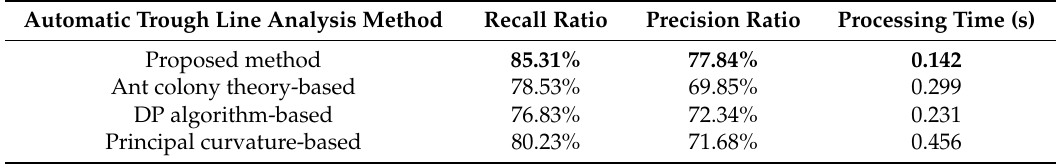
Table 2. Comparison results of the evaluation indicators of different automatic analysis methods of trough